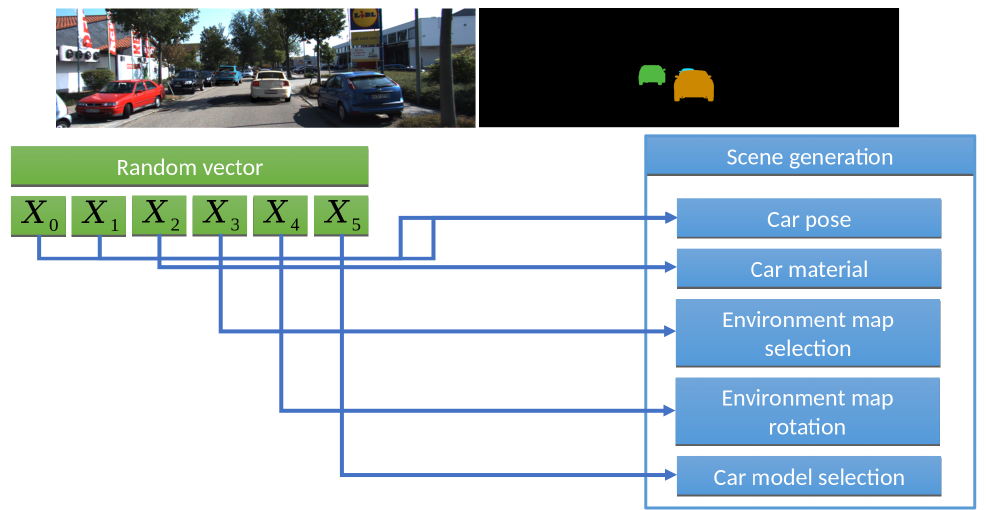
Figure 3. Example of assigning random numbers to scene parameters. The image result is demon- strated at the top left part of the figure. The output masks for synthesized objects are shown at the top right part of the